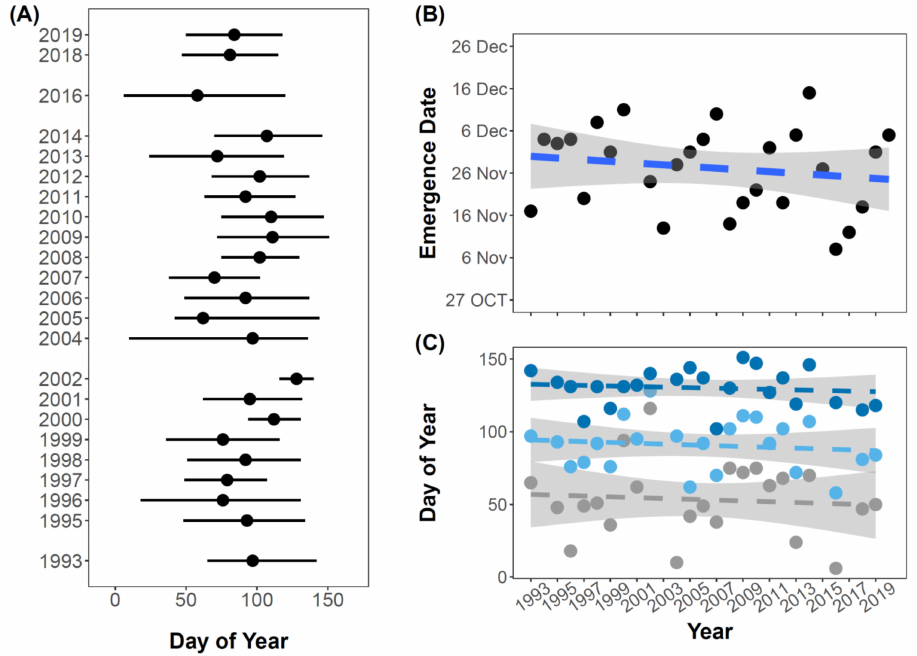
Figure 4. Estimated phenology of a population of C. vicina at the Kerguelen Islands from long-term monitoring data collected during 1993–2019. ( A ) Period of C. vicina activity in the years 1993–2019. The line indicates the duration of activity (time from onset to end of activity) and the points indicate the peak of C. vicina activity period. ( B ) Day of year where the required average accumulated degree days of 439 (calculated from 200th day of year–austral mid-winter when adult flies are inactive) for adult C. vicina emergence has been reached and ( C ) temporal shifts in emergence phenology of C. vicina from 1993–2019. The grey line and points (bottom) represent onset; the light blue line and points (middle) represent peak; and the dark blue line and points represent end of emergence (top). None of the trends were